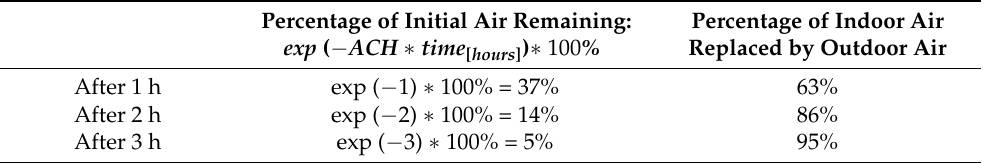
Table 4. Percentage of Air Changes per